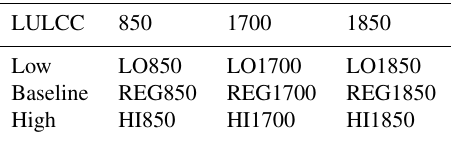
Table 1. Naming of the main experiments based on LUH2 scenar- ios with low, baseline and high LULCC and three different starting years. LULCC 850 1700 1850 Low LO850 LO1700 LO1850 Baseline REG850 REG1700 REG1850 HI850